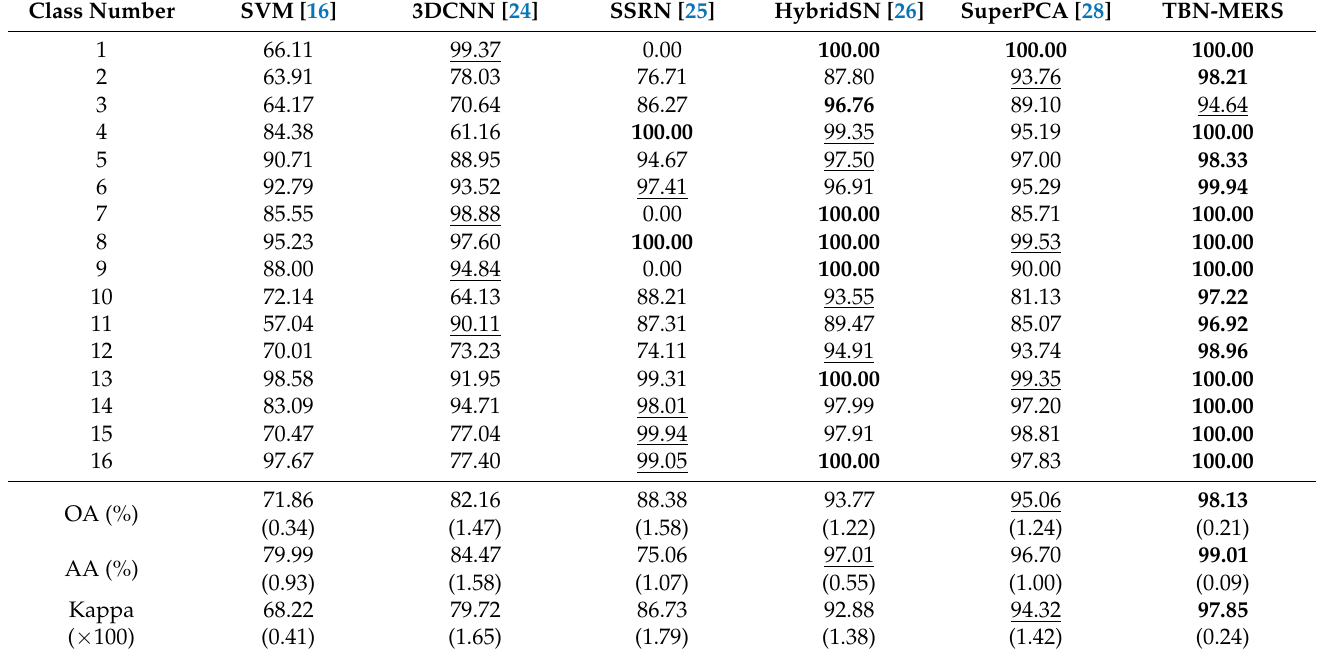
Table 10. Classification results of different methods on IP with 50 samples per